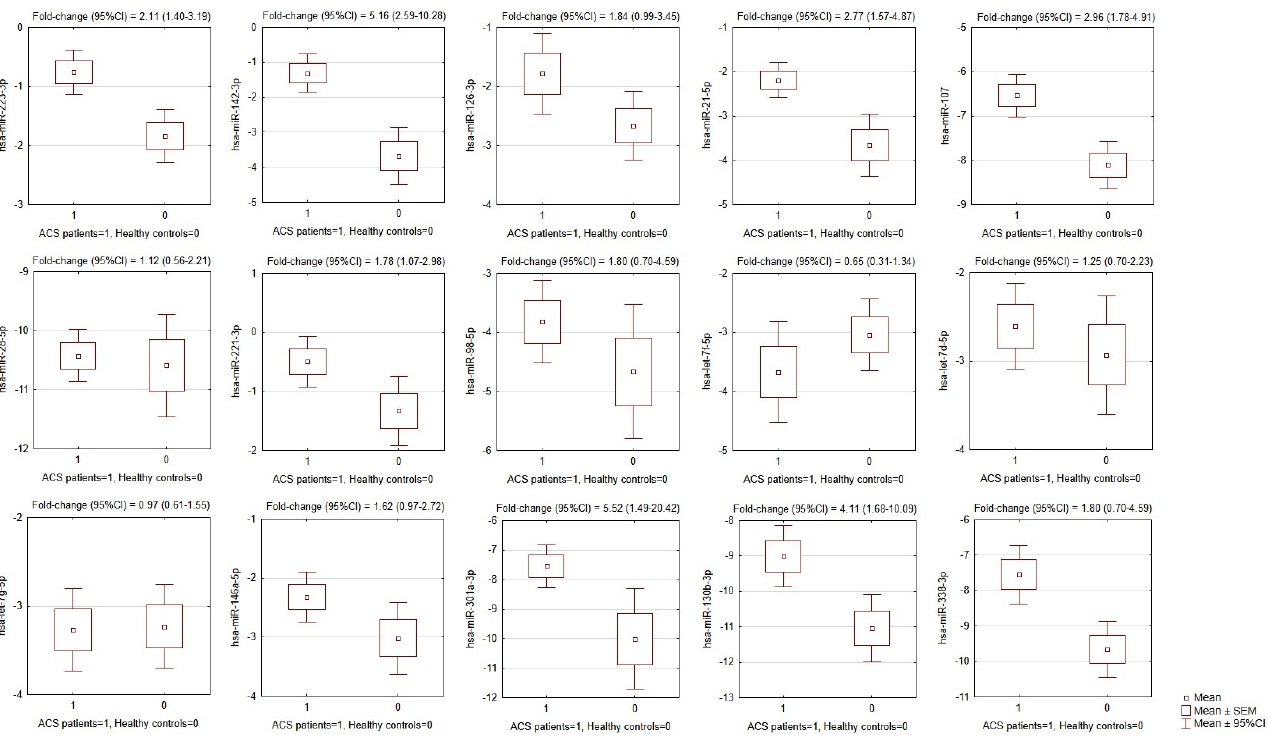
Figure 2. Comparison of miRNA expression in platelets of ACS patients and matched healthy controls. OY axes depict − ∆ Ct values for each given miRNA, presented graphically as the mean, SEM, and 95% CI of expression estimate. Above individual box-plots, the fold-change (95% CI) of miRNA expression in ACS patients in relation to its expression in healthy controls is presented. ACS—acute coronary syndrome, SEM—standard error of mean, CI—confidence interval.